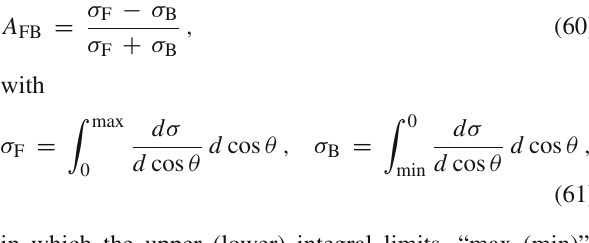
Fig. 13 The forward backward asymmetry in μ + μ − → τ + τ − as a function of s (cid:3) 3 TeV; on the right panel, detailed view around the Z -pole. Line code as in Fig.